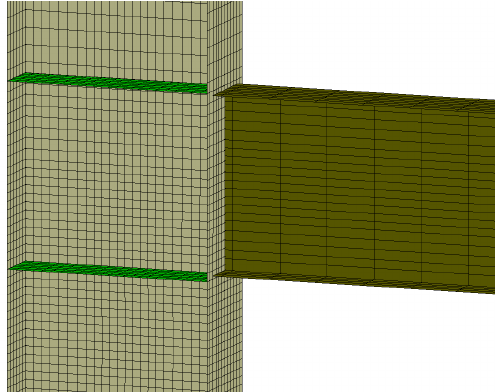
Figure 19. Detail of beam ‐ column connection with web stiffeners.